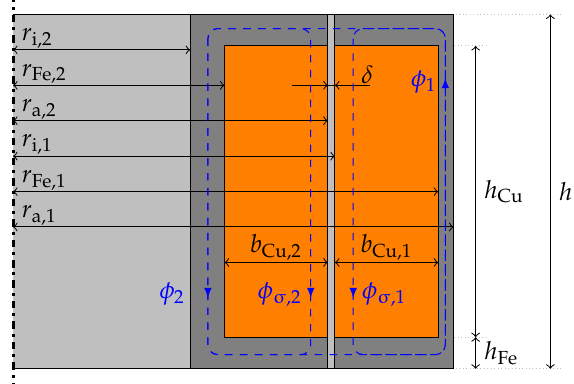
Figure A1. Sketch of the geometrical parameters of the contactless energy transfer system.